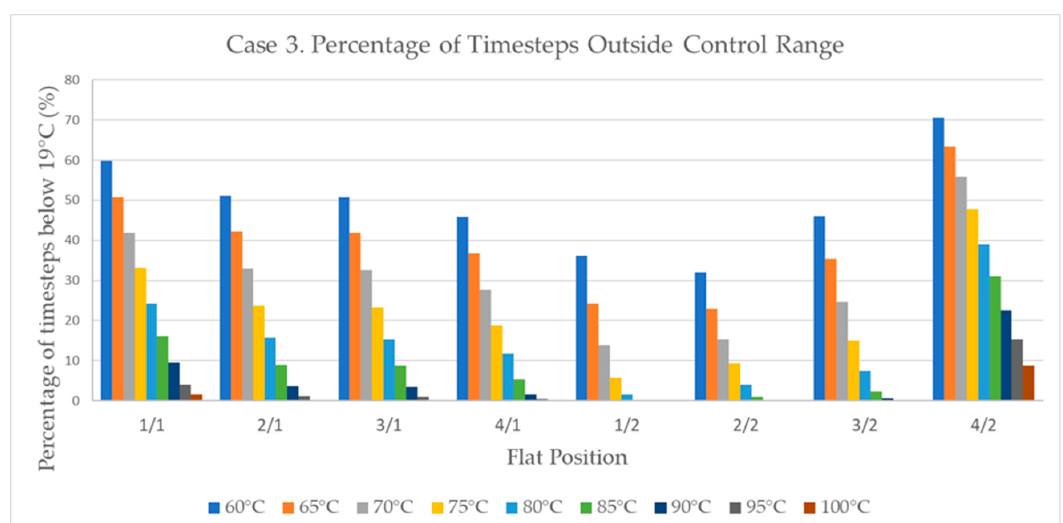
Figure 10. Case 2: no insulation and double glazing.